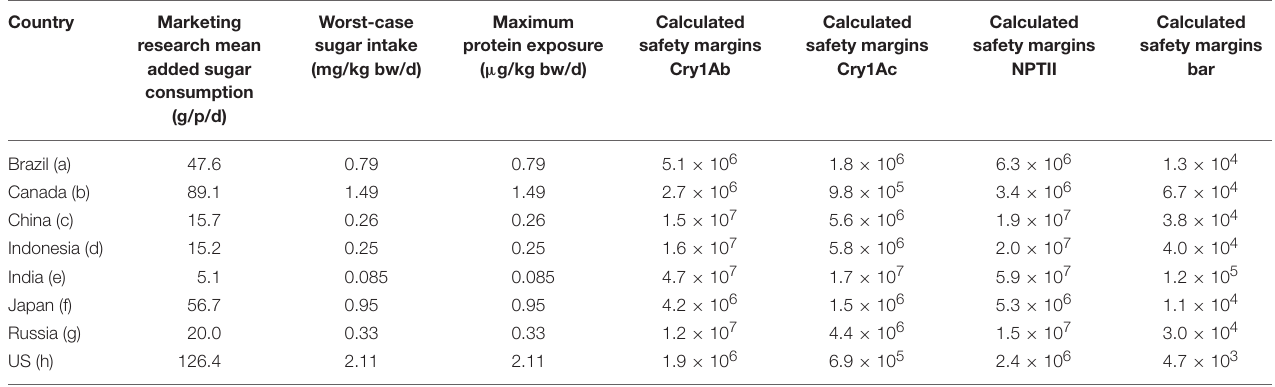
TABLE 4 | Safety margins at “Worst-case” Protein exposure in eight countries. Country